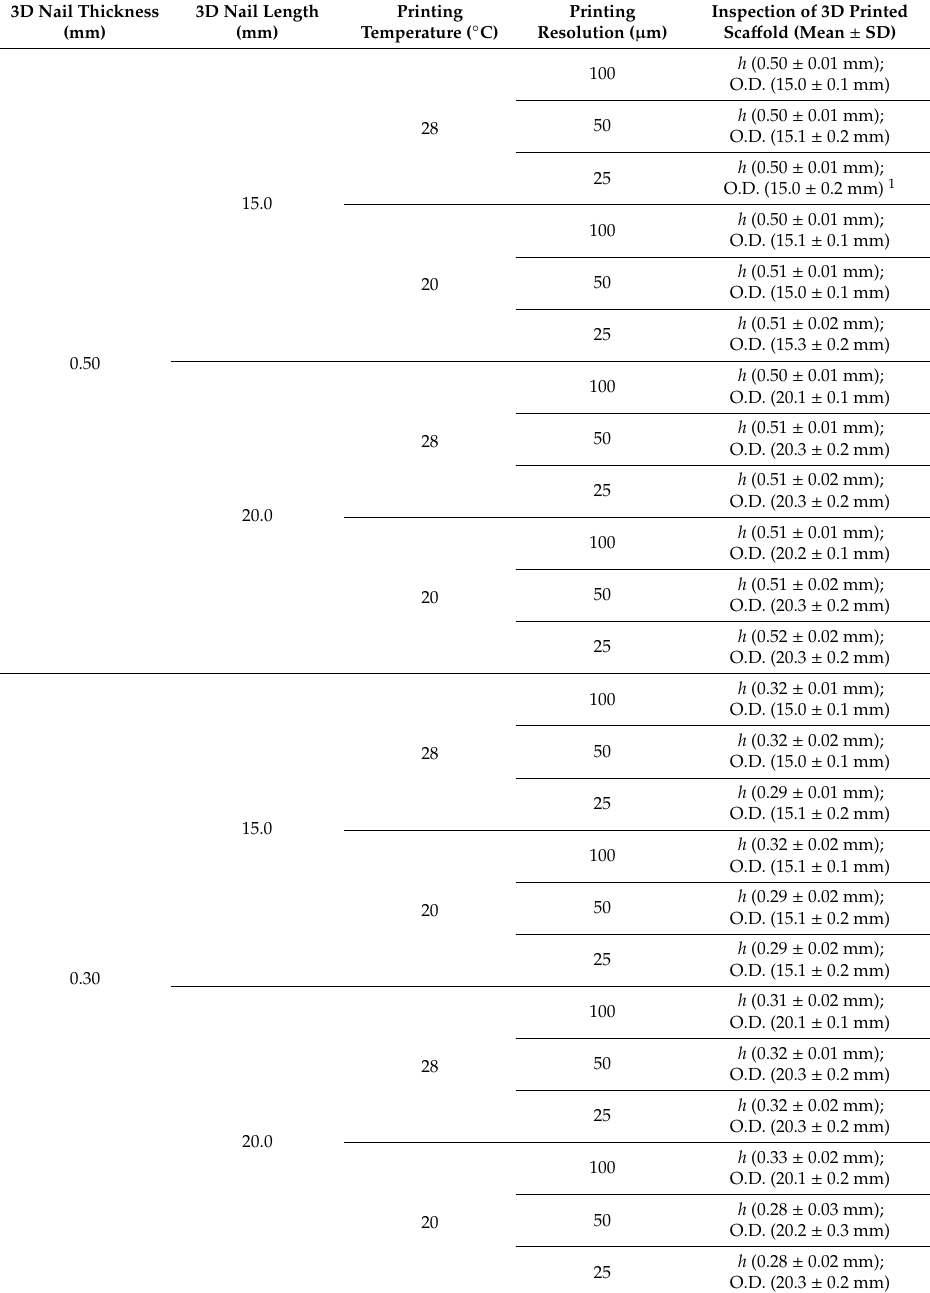
Table 2. Printing conditions (temperature and resolution) for the development of di ff erent 3D printed nails sca ff olds ( n =